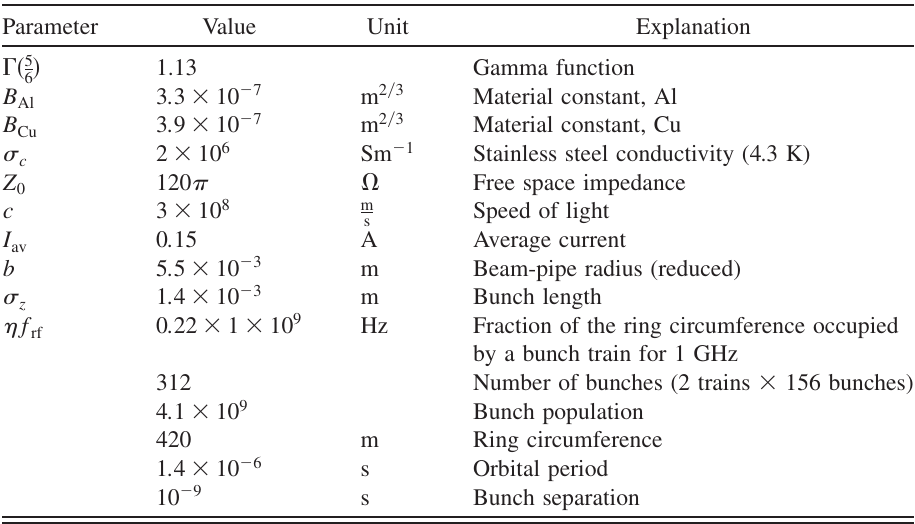
TABLE V. Parameters for image current calculations, see Eqs. (11) and (12); parameter values from [8,26].